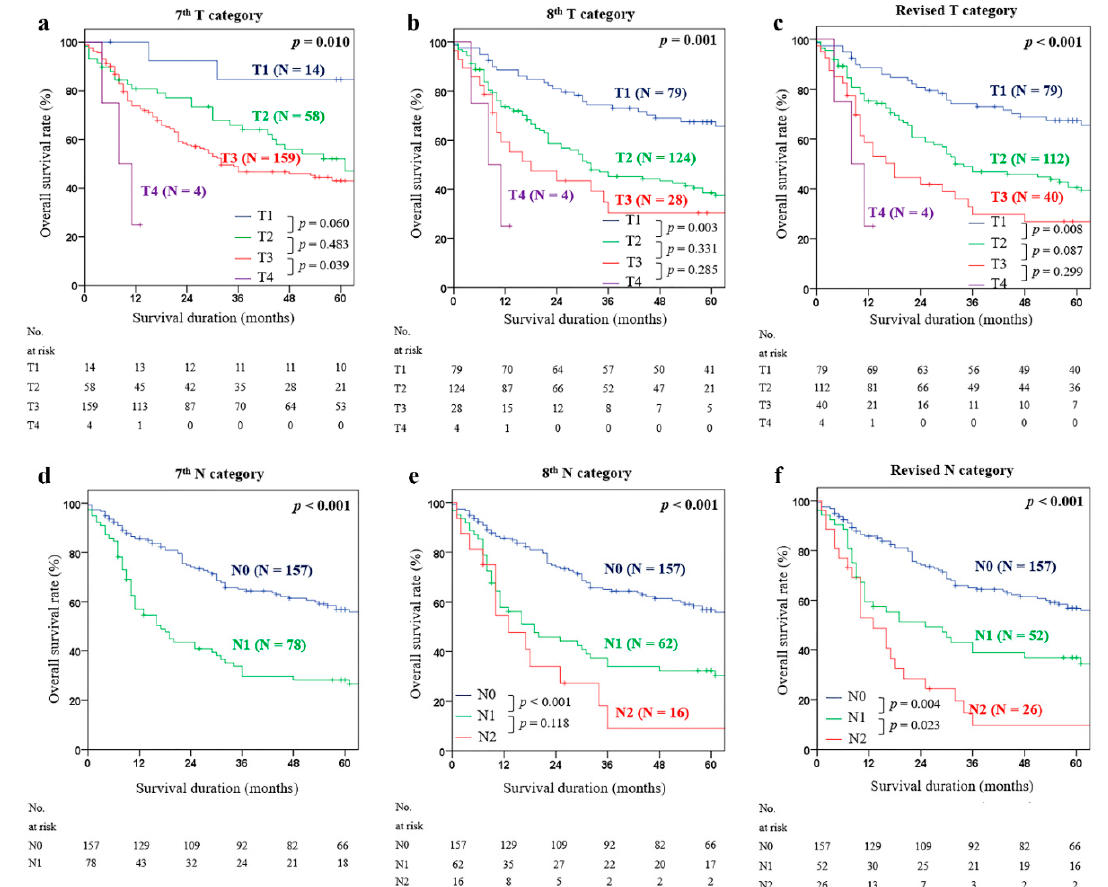
Figure 1. Kaplan–Meier survival analysis of five-year cumulative OSR (overall survival rate), according to ( a ) T category of the AJCC 7th classification, ( b ) T category of the AJCC 8th classification, ( c ) revised T category, ( d ) N category of the AJCC 7th classification, ( e ) N category of the AJCC 8th classification, and ( f ) revised N category.